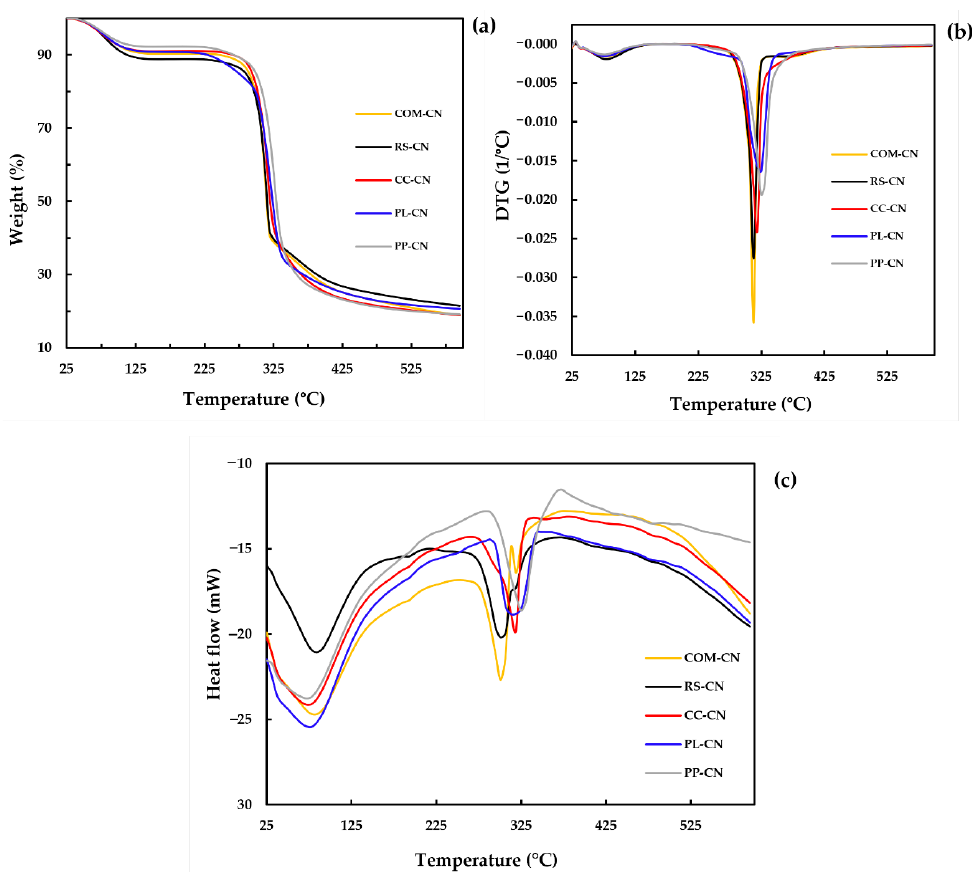
Figure 3. TGA ( a ), DTG ( b ), and DSC ( c ) curves of cellulose nanosphere isolated from different sources compared with commercial cellulose . RS - CN : rice straw cellulose nanosphere; CC - CN : corncob cellulose nanosphere; PL - CN : pineapple leaves cellulose nanosphere; PP - CN : pineapple peels cellulose nanosphere; COM - CN : cellulose nanosphere hydrolyzed from commercial cellulose . Table 2. Thermal properties of cellulose nanosphere from different sources compared with com- mercial cellulose .